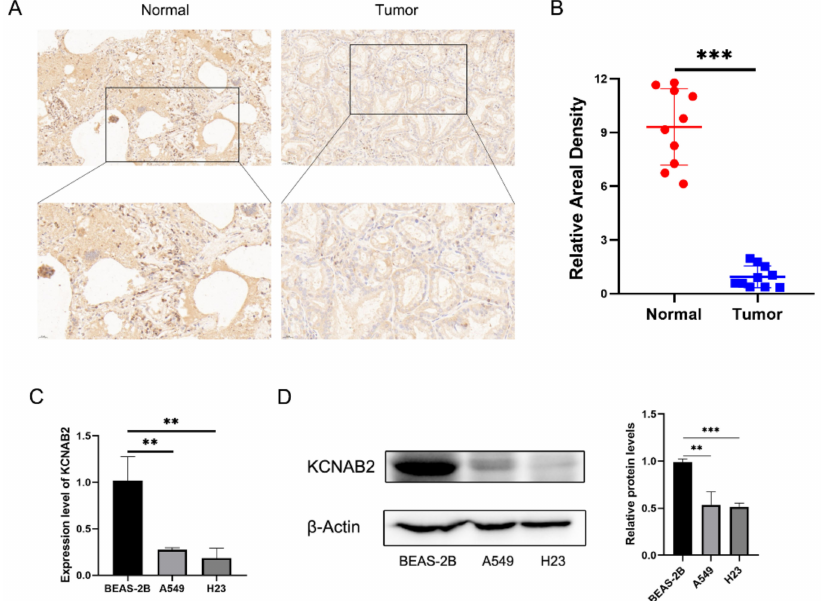
Figure 2. Validation of the decreased expression of KCNAB2 in LUAD using clinical tissues and cell lines. ( A ) Immunohistochemical (IHC) staining of KCNAB2 was performed in tumor tissues (n = 10) and normal tissues (n = 10). Representative images are shown. Score bars, 50 µ m. ( B ) The staining was quantified. The dot plot depicts the means and standard deviation of 10 images of LUAD patient tissues and normal lung tissues. ( C ) Transcriptional levels of KCNAB2 in three different cell lines were examined by real-time PCR. ( D ) Western blot detected the protein expression level of KCNAB2 in three cell lines. ** p < 0.01, *** p <